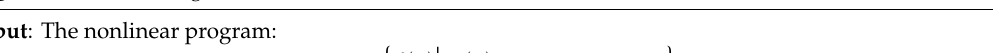
Algorithm 1. CCM